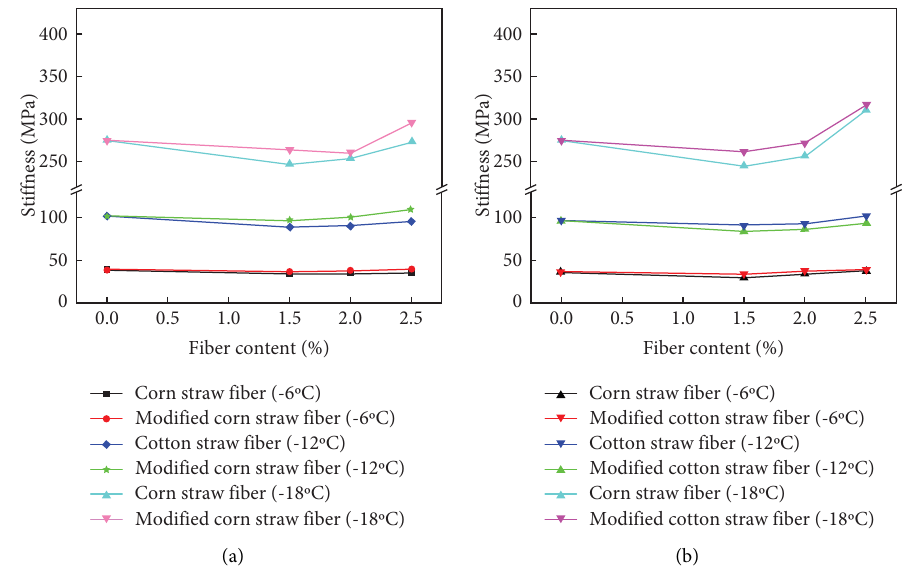
Figure 7: Efects of temperature and fber content on stifness of straw fber asphalt binder. (a) Corn straw fber. (b) Cotton straw fber.